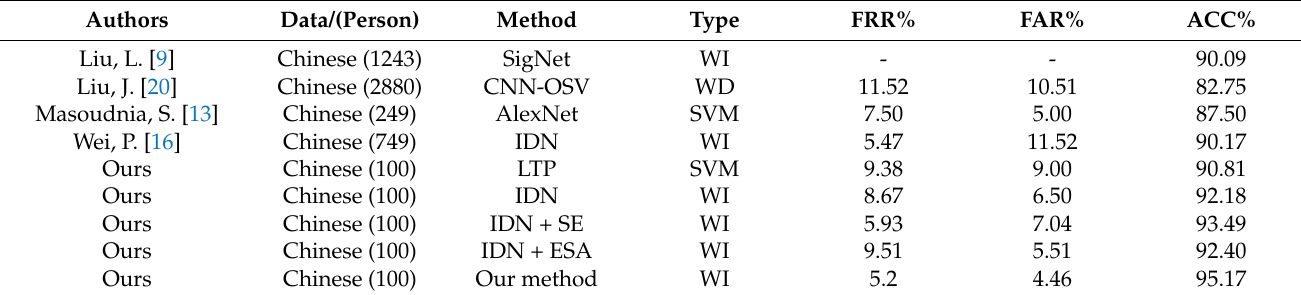
Table 1. Signature verification results and comparative experiments of Chinese